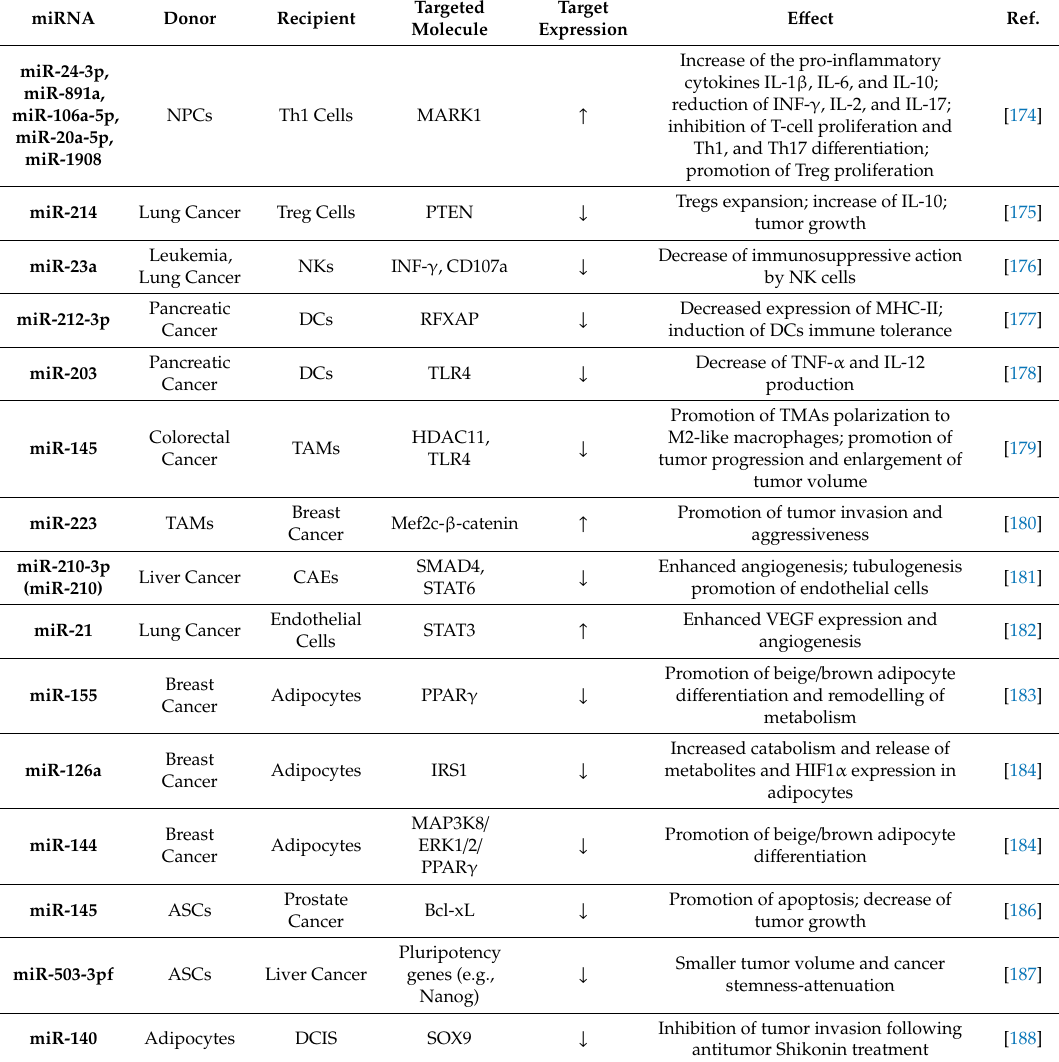
Table 2. Examples of exosomal miRNAs involved in cell–cell communication within the tumor microenvironment.